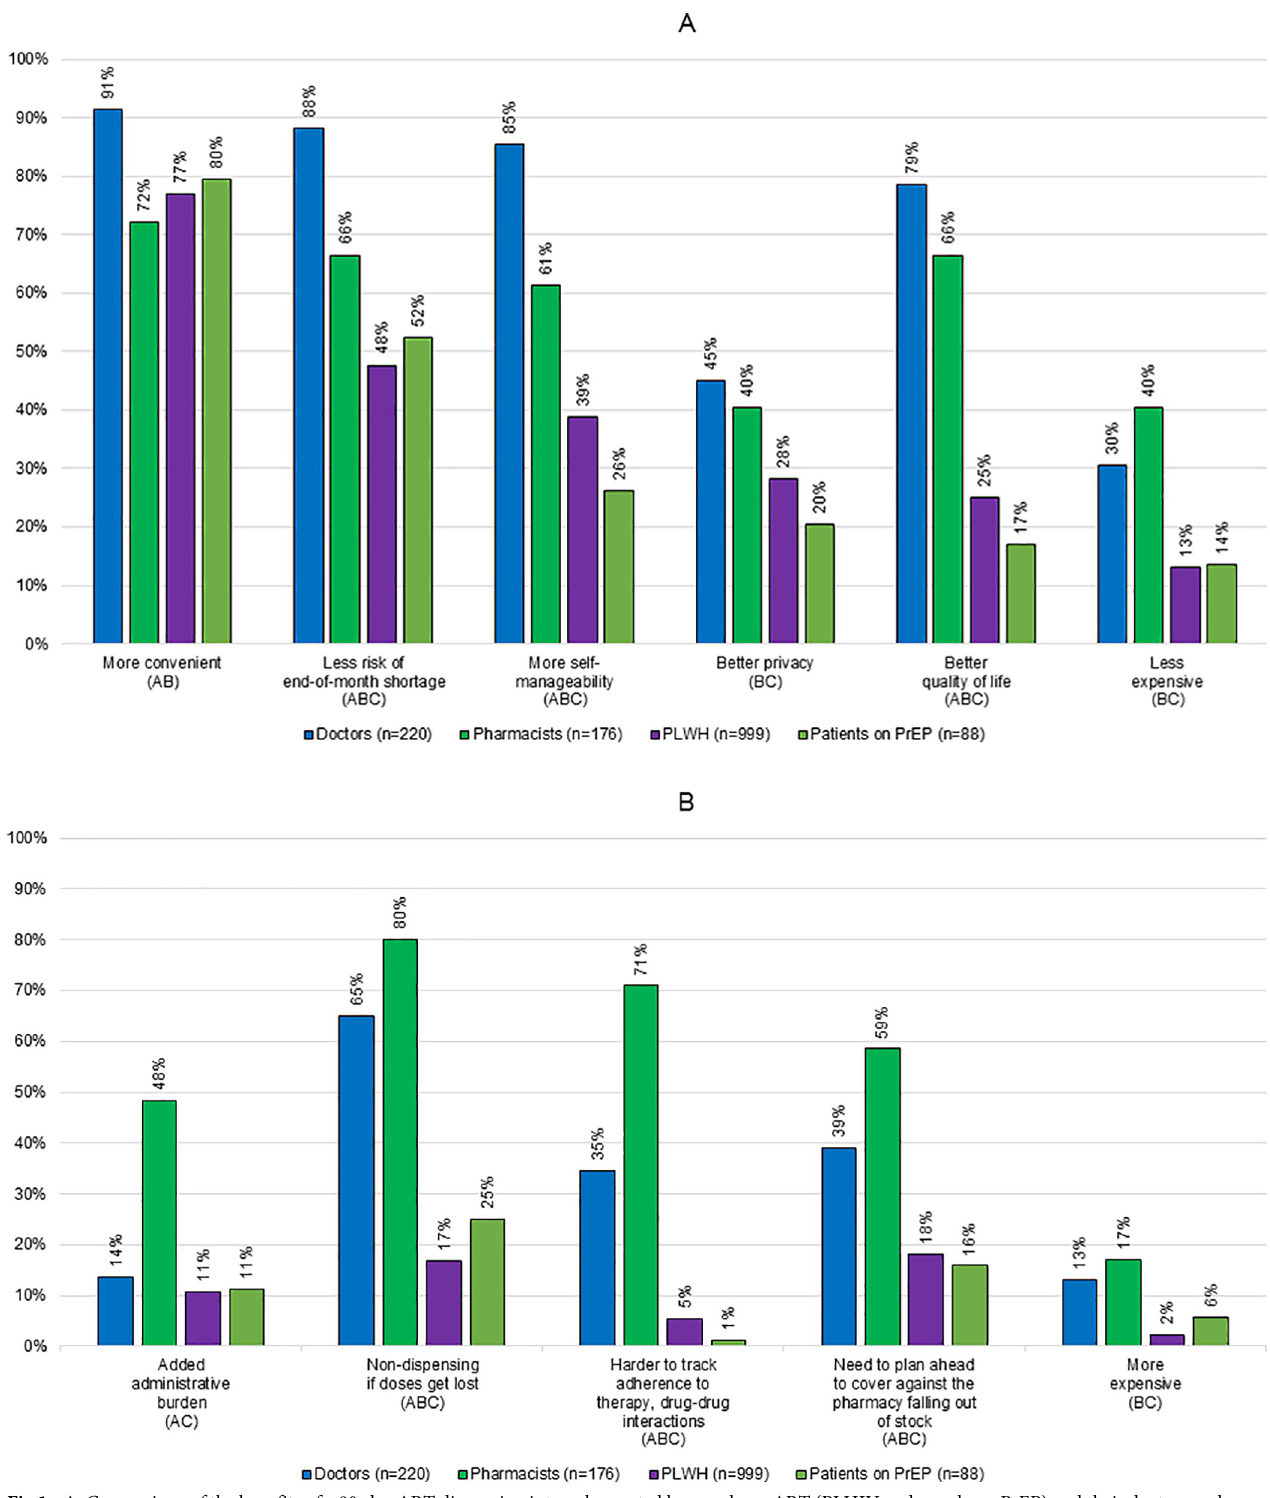
Fig 1. A. Comparison of the benefits of a 90-day ART dispensing interval reported by people on ART (PLHIV and people on PrEP) and their doctors and pharmacists. A = significant difference between doctors and pharmacists, B = significant difference between doctors and people on ART (PLHIV and people on PrEP), C = significant difference between pharmacists and people on ART (PLHIV and people on PrEP). B. Comparison of the limitations of a 90-day ART dispensing interval reported by people on ART (PLHIV and people on PrEP) and their doctors and pharmacists. A = significant difference between doctors